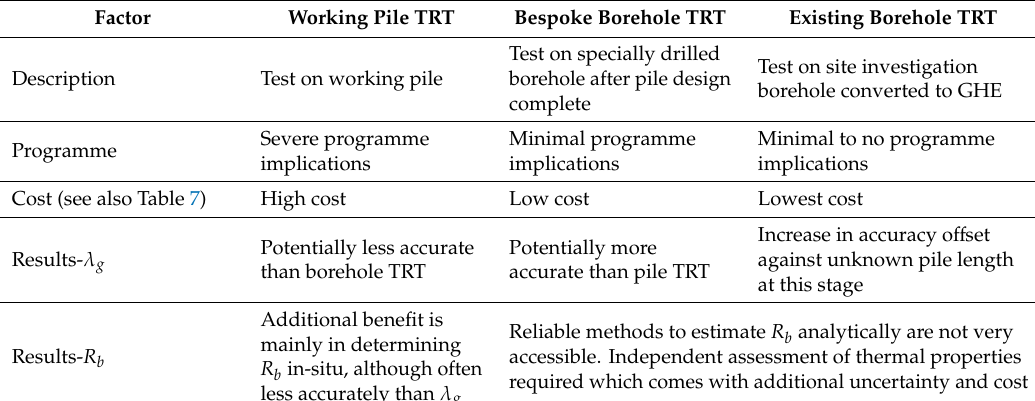
Table 6. Advantages and disadvantages of pile and borehole thermal response testing for energy pile